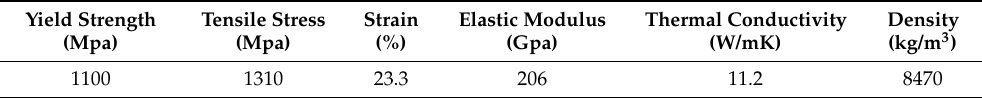
Table 2. Mechanical and physical properties of IN718.